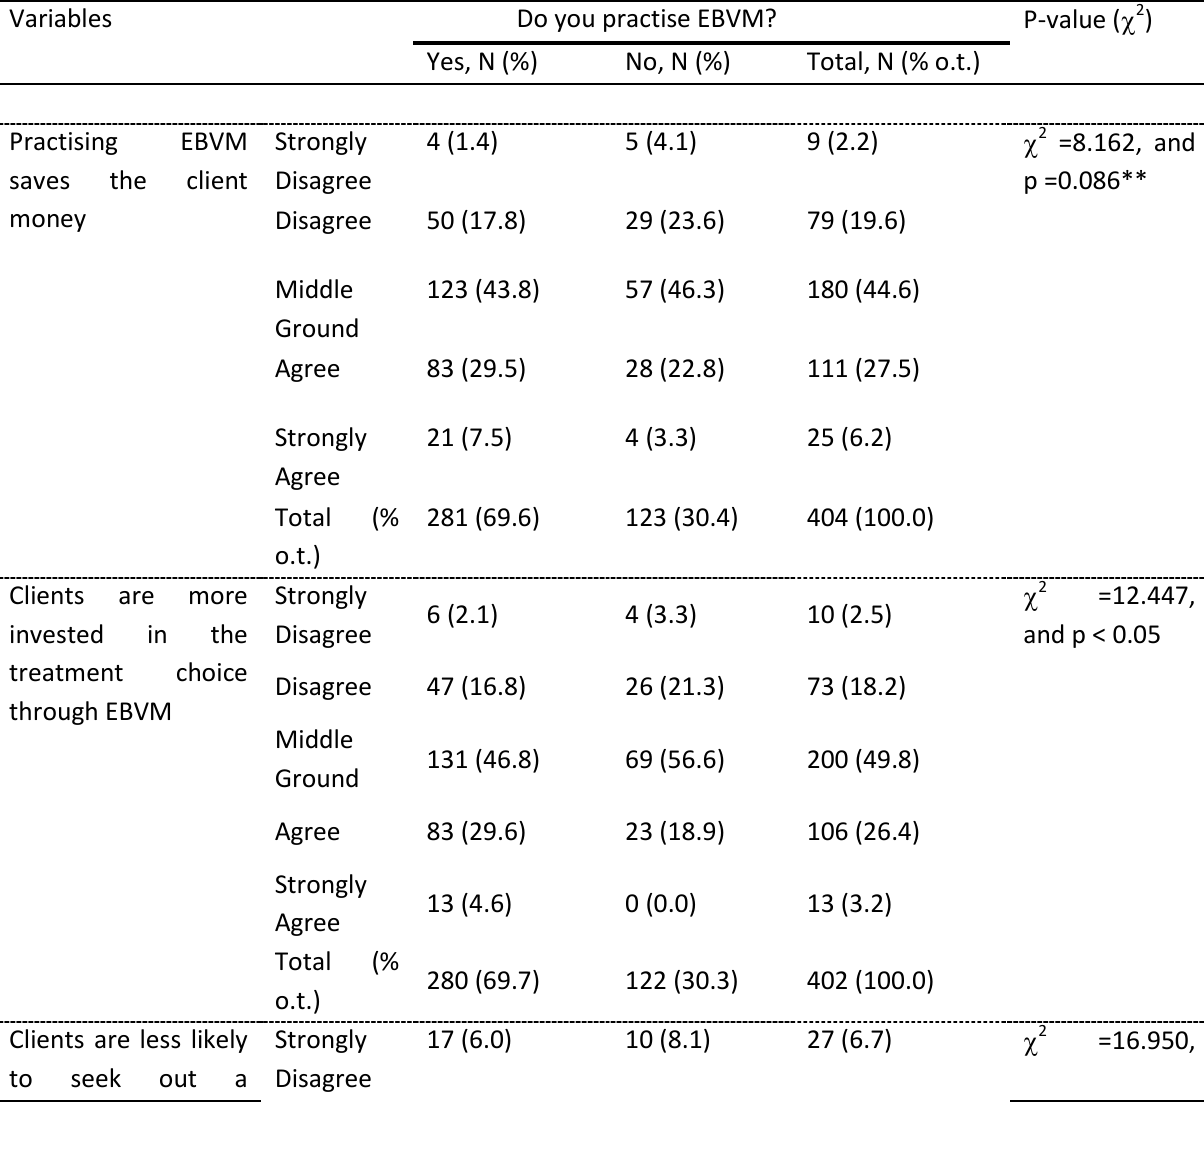
Table 6 : Perceived benefits to the client III